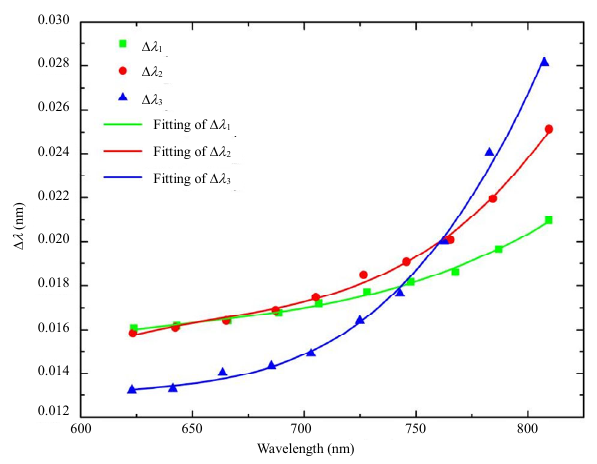
Fig. 7 Fitted curves for the measurement accuracy of the resonant wavelength.